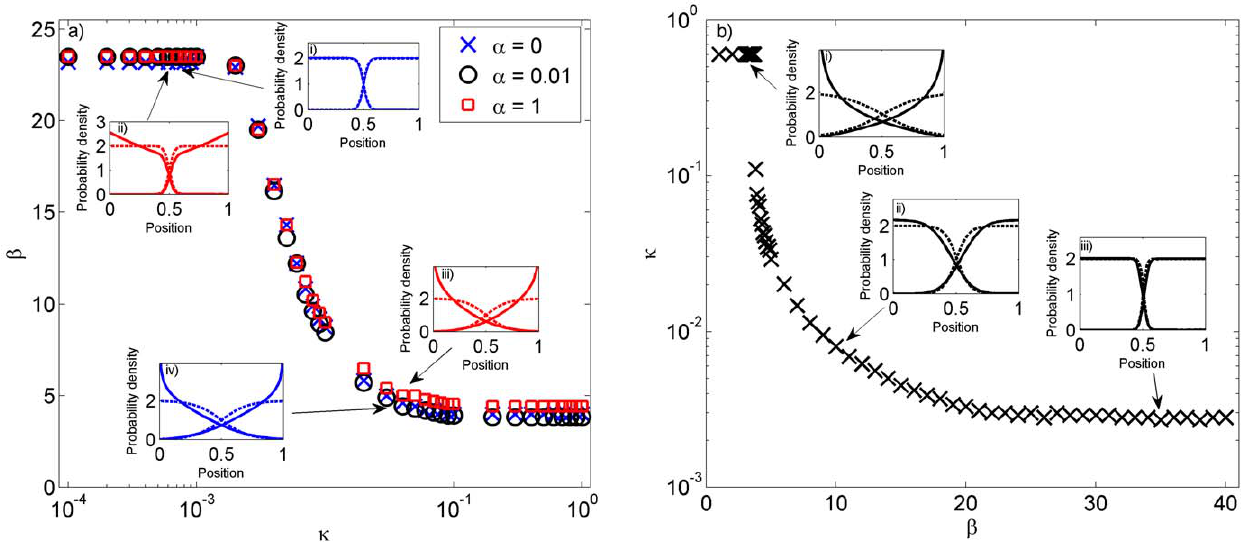
Figure 5. Comparison with a previous model of territory formation. The parameter b from the reaction-diffusion model introduced in [9] (see also main text) is compared with the parameters a and k from the 1D analytic model introduced here. Panel (a) shows the b -value that gives the best-fit animal marginal distribution curve for each given value of a and k . The insets compare the probability distributions for particular values of a and k , where the solid lines represent our model and the dashed lines the reaction-diffusion model. The values used are (i) k ~ 0 : 0007 , a ~ 0 : 0001 , (ii) k ~ 0 : 0007 , a ~ 1 , (iii) k ~ 0 : 04 , a ~ 0 : 0001 , (iv) k ~ 0 : 04 , a ~ 1 . Panel (b) shows the best fit k -value for a given b . The b -values used for the insets are (i) b ~ 3 , (ii) b ~ 10 , (iii) b ~ 35 . Low values of a always give a better fit to a given marginal distribution from the reaction-diffusion model than higher values and do not affect the value of k that gives the best fit. Therefore we set a ~ 0 when performing the fitting for panel (b). Low values of a and k together with high values of b tend to give rise to good fits, but outside this range the two models show quite different